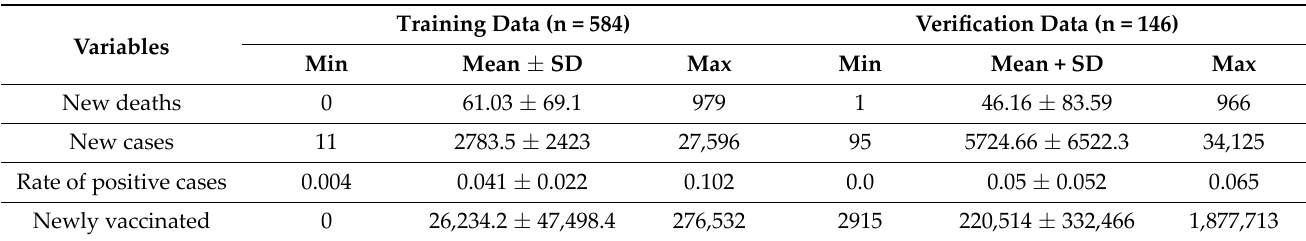
Figure 6. Time series plot for the average daily mortality due to COVID‑19 in the region. The descriptive statistics in Table 2 present the average, maximum, and minimum values for the target and all the input variables of the training (70% of the dataset and n = 584) and verification datasets (30% of the dataset and n = 146) from 01 April 2020 to 01 April 2022. The average mortality due to COVID 19 was (61.03 ± 69.1) for the training dataset, and it was (46.16 ± 83.59) for the verification dataset. The average number of new daily cases was (2783.5 ± 2423) for the training and (5724.66 ± 6522.36) for the verification data, while the rates of confirmed positive cases per day were 0.041 ± 0.022 and 0.05 ± 0.052 for the training and verification datasets, respectively. The daily vaccine coverage and hospital beds per 1000 people, which are also presented in the table, showed that the average daily vaccine coverage was (26234.2 ± 47498.4) and (220514 ± 332466) for the testing and verification data, respectively. The hospital beds/1000 people were (28.25 ± 3.50) and (20.4 ± 0.5623) for the training and verification datasets, respectively. Table 2. Descriptive statistics of COVID-19 mortality and input variables.